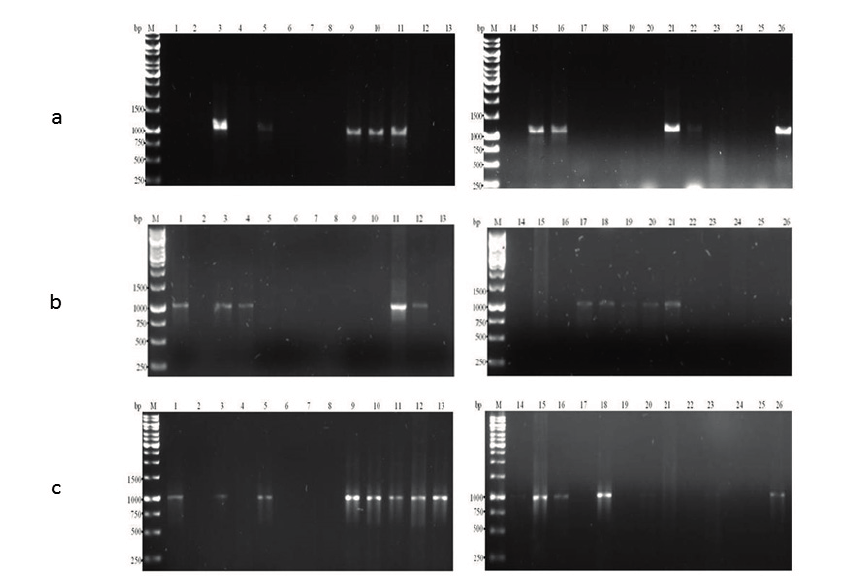
Figure 2. ( a ) Ethidium bromide-stained gels of Polymerase Chain Reaction (PCR) amplification products obtained from different rotten vegetable samples using set 1 and set 4 (M101F + M1208R and M57F + M296R). Lane 1, 2, 4, 6, 7, 8, 12, 13, 14, 17, 18, 19, 20, 23 and 24: No amplification; Lane 3, 5, 9, 10, 11, 15, 16, 21, 22 and 26: Amplicon size Table 2. ( b ) Ethidium bromide-stained gels of PCR amplification products obtained from different rotten vegetable samples using M182F + M1190R. Lane 2, 4, 6, 7, 8, 14, 17, 19, 20, 21, 22, 23, 24 and 25: No amplification; Lane 1, 3, 5, 9, 10, 11, 12, 13, 15, 16, 18 and